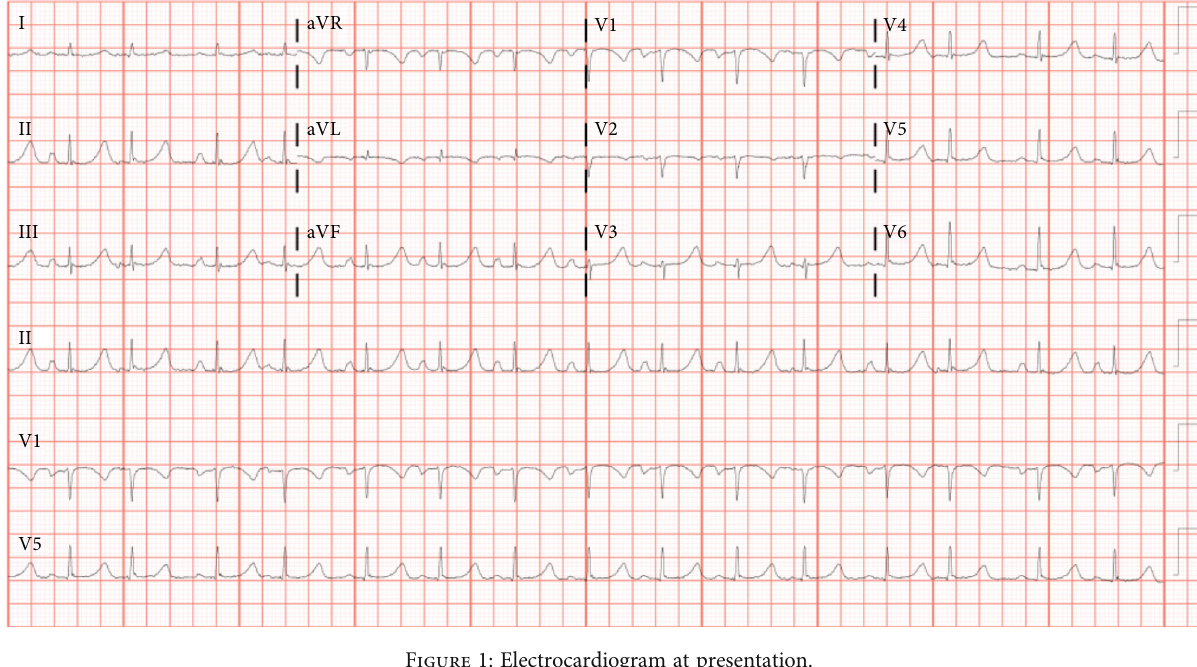
Figure 1: Electrocardiogram at presentation.